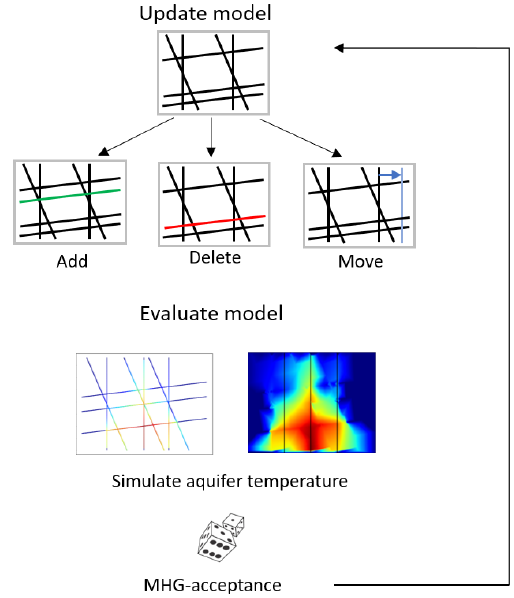
Figure 2. The transdimensional DFN inversion algorithm. Every iteration of the inversion consists of two phases. In the model update phase, the DFN is modified randomly, via fracture deletion, addition or horizontal translation of a fault. In the model evaluation phase, the updated model is evaluated by simulating the temperature field in the